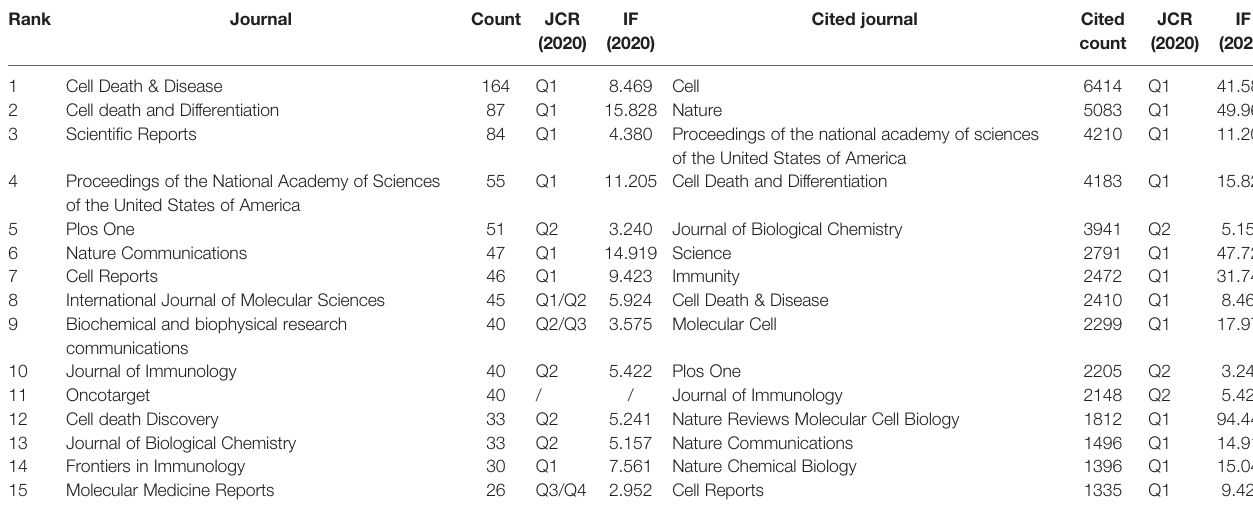
TABLE 3 | Top 15 journals and co-cited journals related to necroptosis.